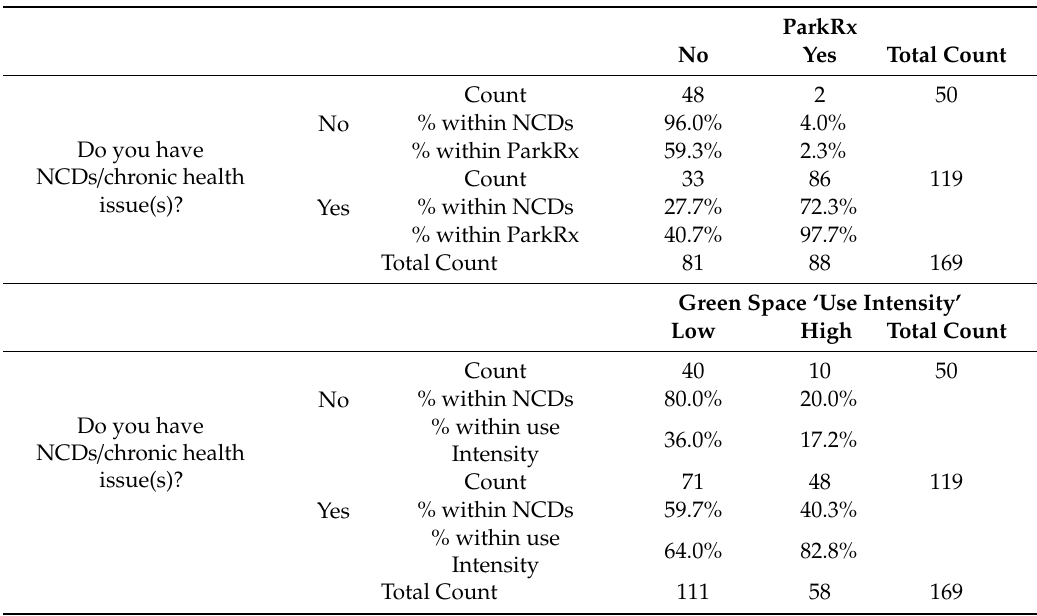
Table 4. Green space use variations among noncommunicable diseases (NCDs) and park prescription (ParkRx) groups.